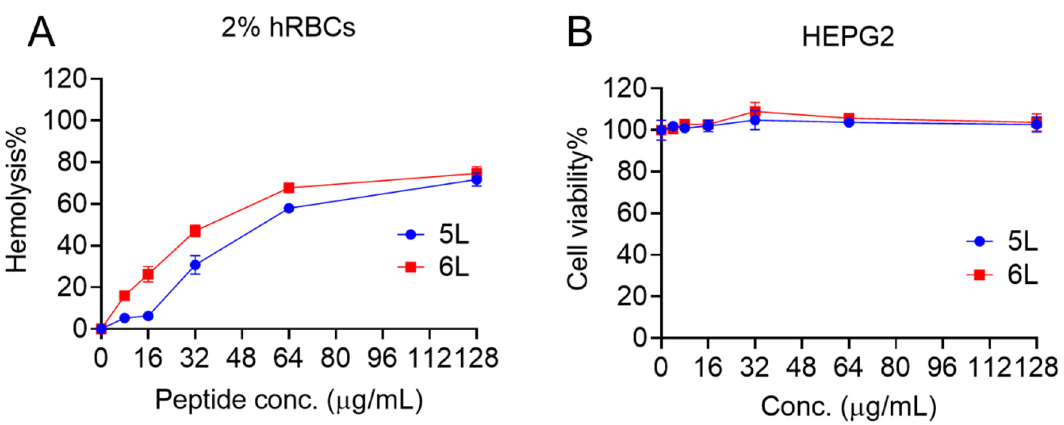
Figure 3. Cytotoxicity of LfcinB6-derived peptides. ( A ) Hemolysis potential of 5L and 6L to human red blood cells, ( B ) cellular toxicity to HepG2 cell lines.